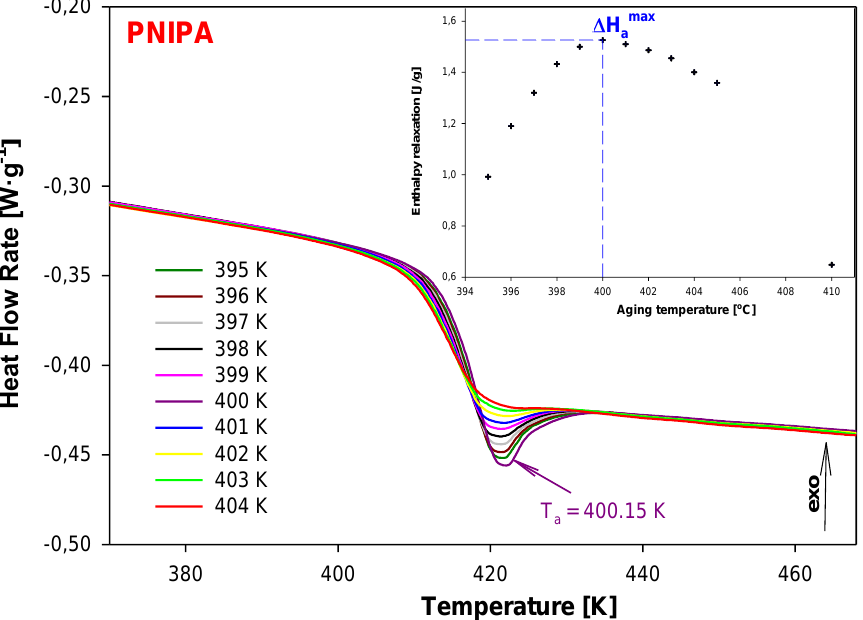
Figure 5. The dependence of heat flow rate on temperature obtained after the isothermal aging of PNIPA at different aging temperatures in the range of 395 – 404 K for 30 min. The maximum enthalpy recovery was obtained at T a = 400.15 K. The insert shows the enthalpy recovery versus aging temperature.